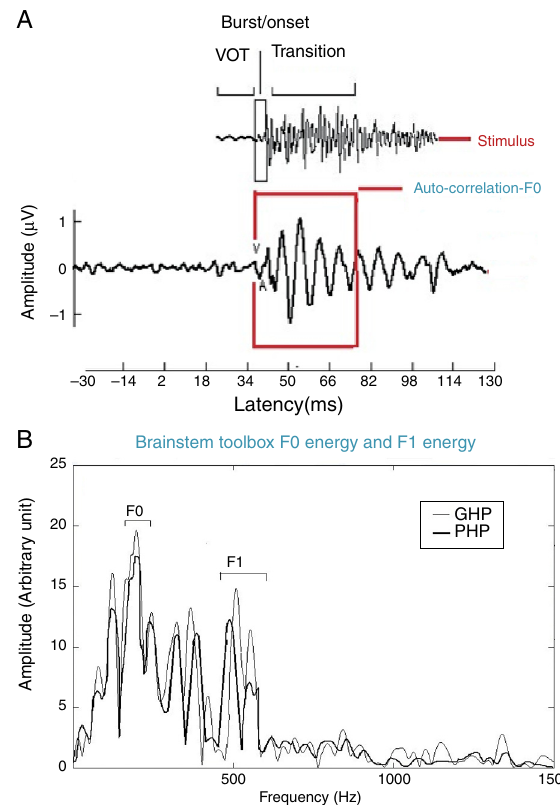
(A) Response corresponding to stimulus at transition portion of /da/ stimulus; (B) showing grand average spectrum of GHP and PHP sub-group. (B) Fundamental frequency and fre- quency of first formant in FFR for /da/ stimulus.